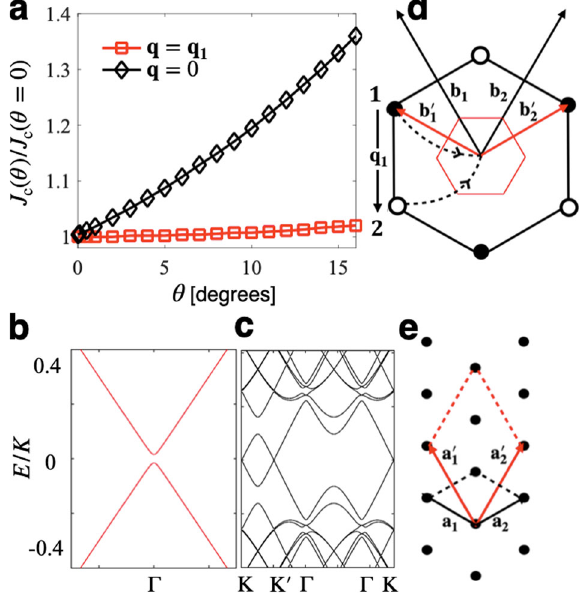
Fig. 3 Moiré superlattices of the Yao-Lee bilayer. a Critical inter- layer exchange J c θ ð Þ , as a function of twisting angle θ , and for q = 0 q Þh i (Eq. (13)), and q = q 1 in the effective interlayer hybridization χ 00 ð in units of J c θ ¼ 0 ð Þ . The q = q 1 solution is energetically preferred. The spectrum for ( b ) q = q 1 and ( c ) q = 0 in units of the intra-layer coupling K (Eq. (2)). d Moiré reciprocal unit cells for J < J c (black) and J > J c (red). 1 and 2 denote the Dirac points of the two layers which are separated by q 1 for J < J c , corresponding to vanishing inter-layer hybridization. When the latter acquires a fi nite value for J > J c and q = q 1 , the two Dirac points are shifted to the Γ point of the folded BZ, and are subsequently gapped. e Schematic illustration of the moiré lattice vectors for J < J c (black) and J > J c (red) corresponding to zero and non-zero ( q = q 1 ) hybridization,